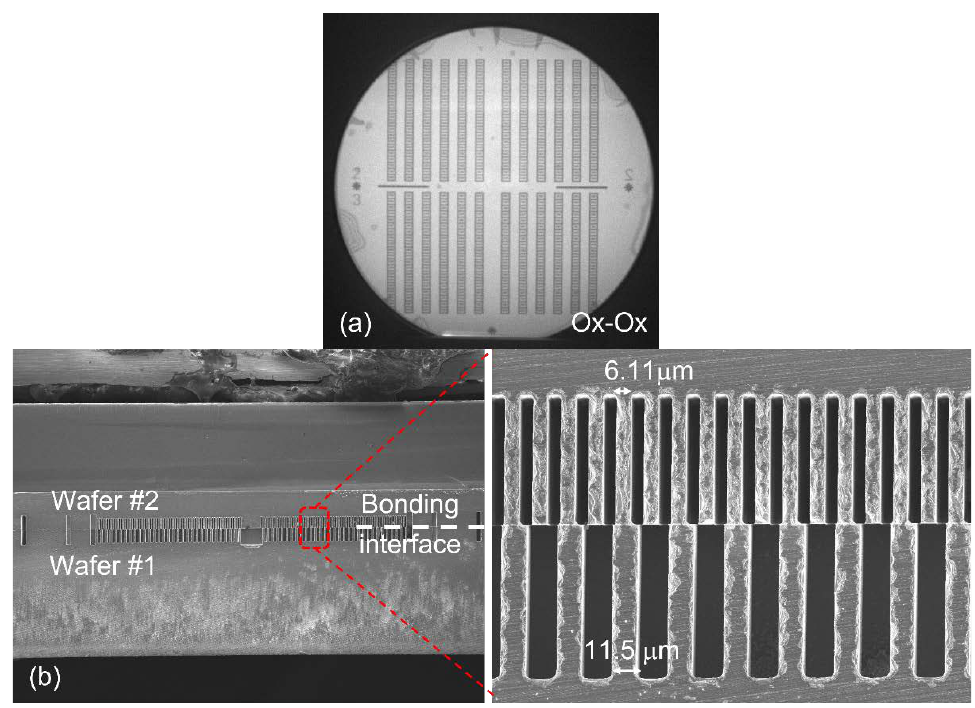
Figure 4. IR images for ( a ) oxide-to-oxide wafer bonding using two patterned wafers with a 40 µm deep trench and ( b ) cross-sectional SEM image of the bonded wafers.